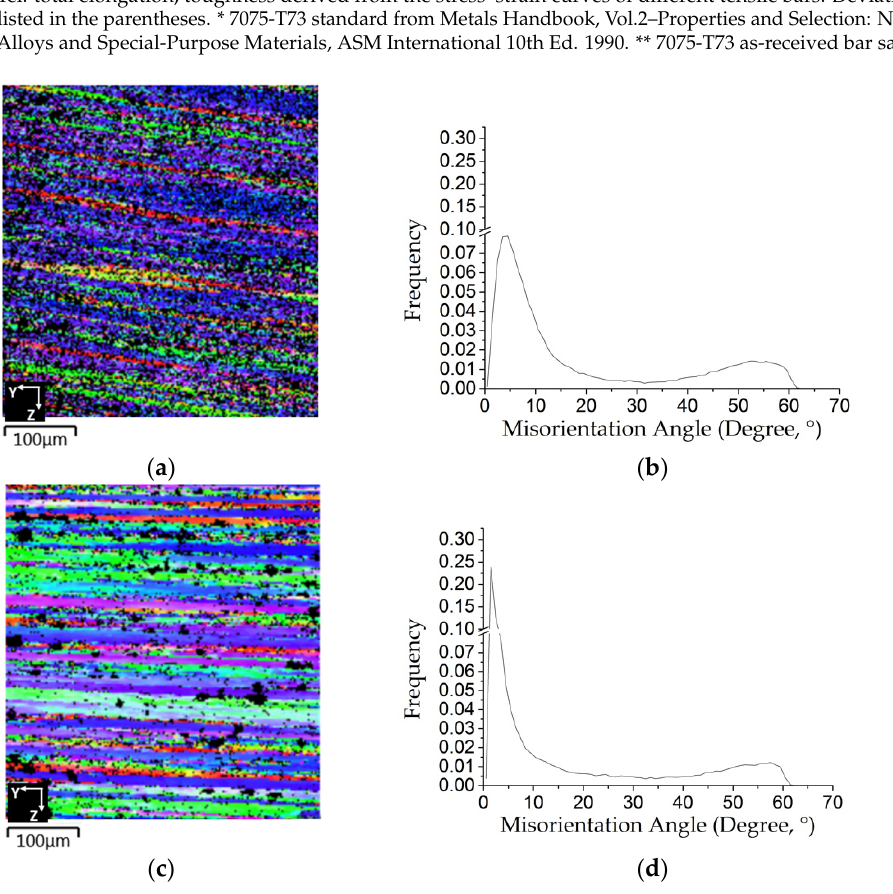
Figure 4. EBSD analysis results: ( a , c ) inverse pole figure (IPF); ( b , d ) misorientation angle distribution for ( a , b ) RF50, ( c , d ) HF50.